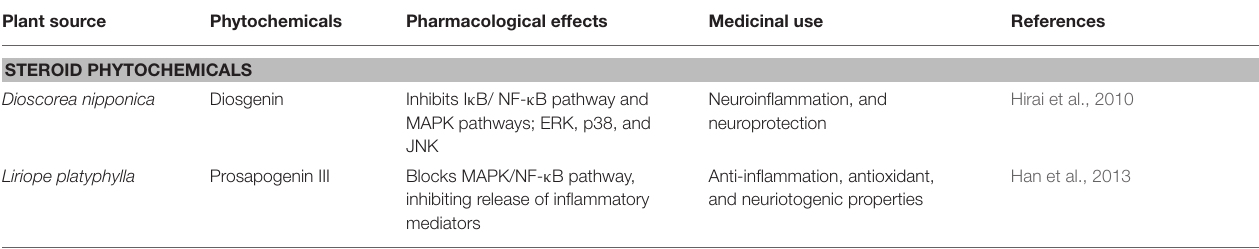
TABLE 1 | Steroid phytochemicals that affect Alzheimer’s